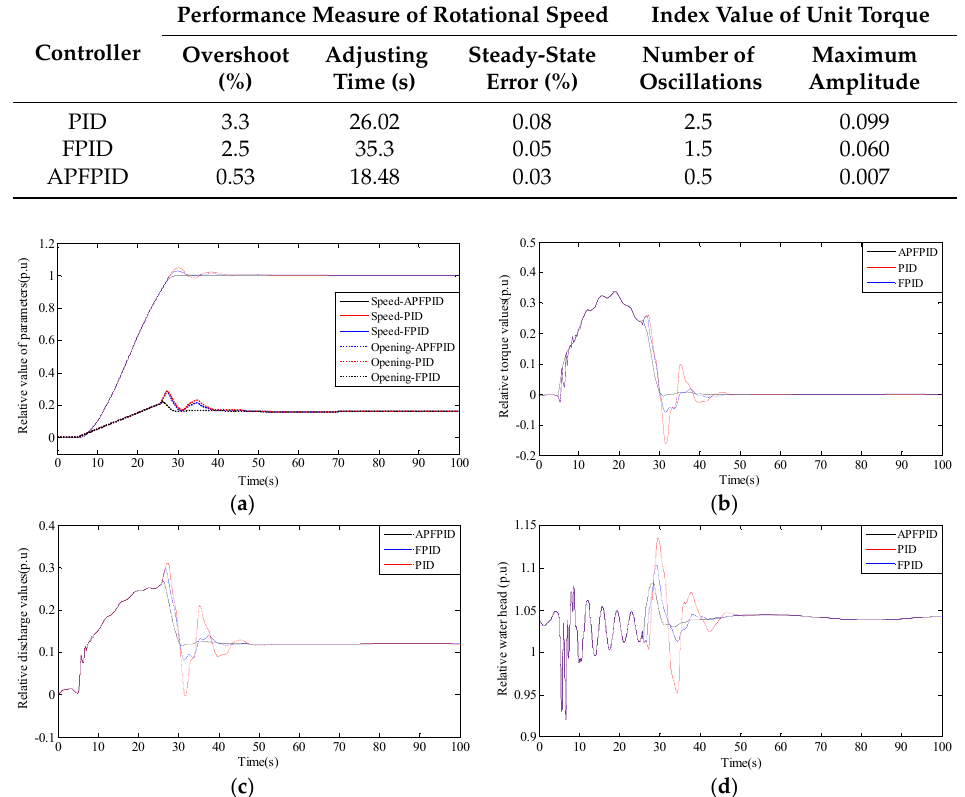
Table 3. Performance indexes of the simulated PSU with different controllers in the start-up process.